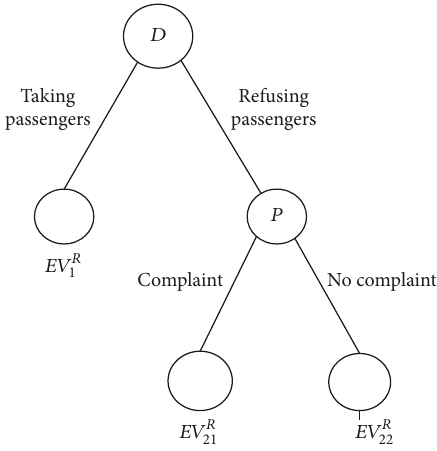
Figure 2: Driver strategies and prospect